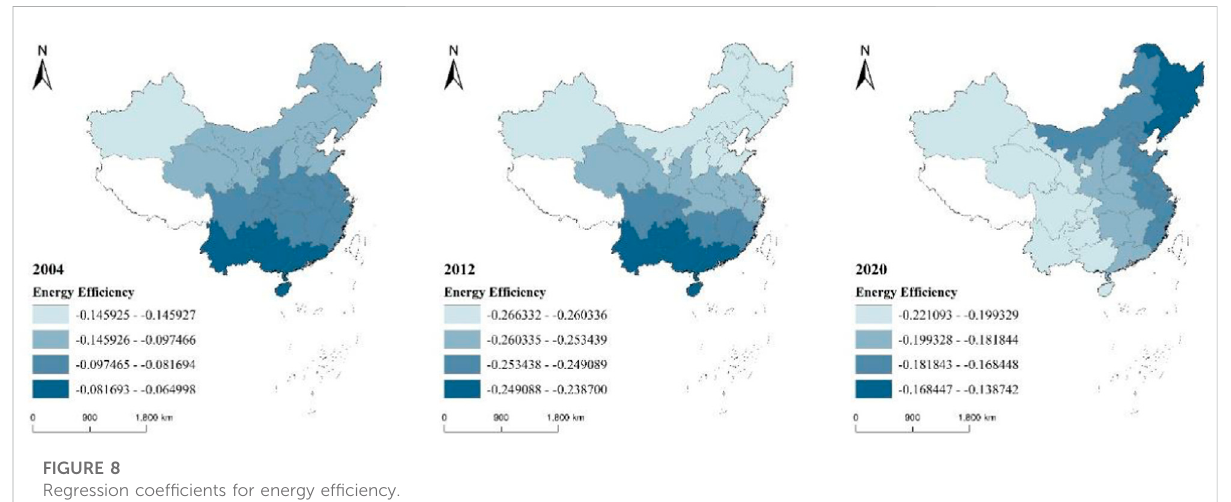
FIGURE 8 Regression coef fi cients for energy ef fi